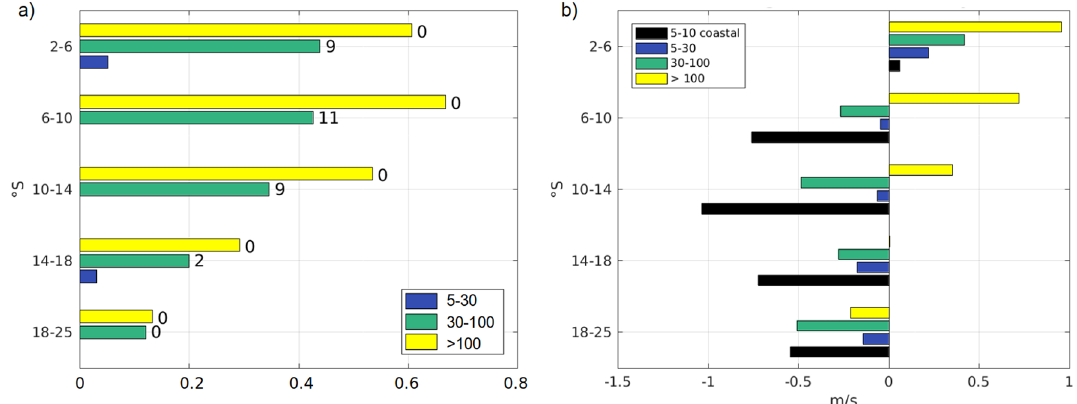
Figure 7. ( a ) Correlation between equatorial MHWs and coastal MHWs for 5 coastal latitude bands. The correlation is presented for events of duration 5–30 days (blue), 30–100 days (green) and longer than 100 days (yellow). The number indicates the lag for the highest correlation, in days. ( b ) Averaged wind anomaly on the first day of a MHW event. Results are presented for events of duration 5–30 days (blue), 30–100 days (green), longer than 100 days (yellow) and for events 5–10 days located less than 100 km from the shore (black). The figure was created using Matlab R2020b (https:// matlab. mathw orks. advection and entrainment in the eastern Pacific and by the difference in mixed layer depth in both regions. Since long MHWs are mostly related to strong EN events the same logic could apply and a mix of advection and entrainment acting on mixed layers of different depth could drive anomalously warm temperatures at the same time in the coastal and equatorial boxes. MHWs with duration ranging from 30 to 100 days in the coastal domain also show significant correlation ◦ S (0.35–0.45) with equatorial MHWs of the same duration north of 14 with a lag between the equator and the coast of about 10 days. Considering the distance between the equatorial and coastal boxes a 9–11 days lag would − 1 yield a propagation speed of the signal between 2.2 and 2.8 m s . Since intraseasonal Kelvin waves, for time − 1 scales of ∼ 50 − 70 days , have been shown to propagate at ∼ 2.3 − 2.6m s they are a good candidate to explain